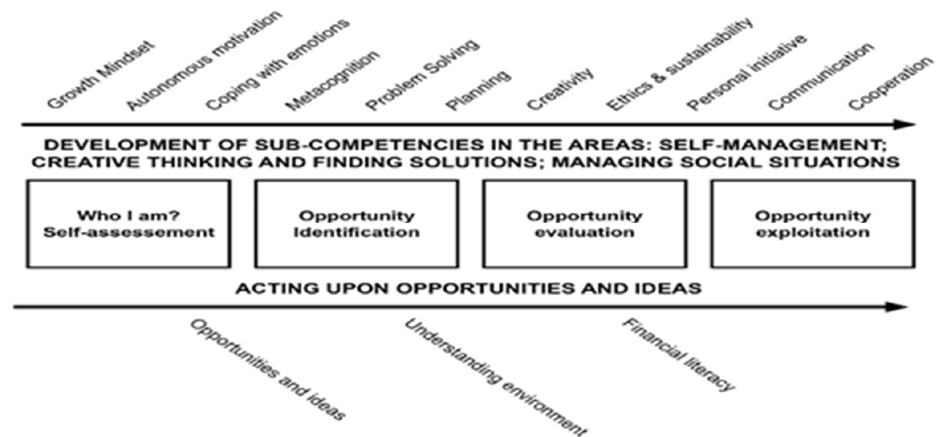
Figure 3. Development of sub-competences of entrepreneurship competence during the different stages of the entrepreneurial process. Source: created by the authors.